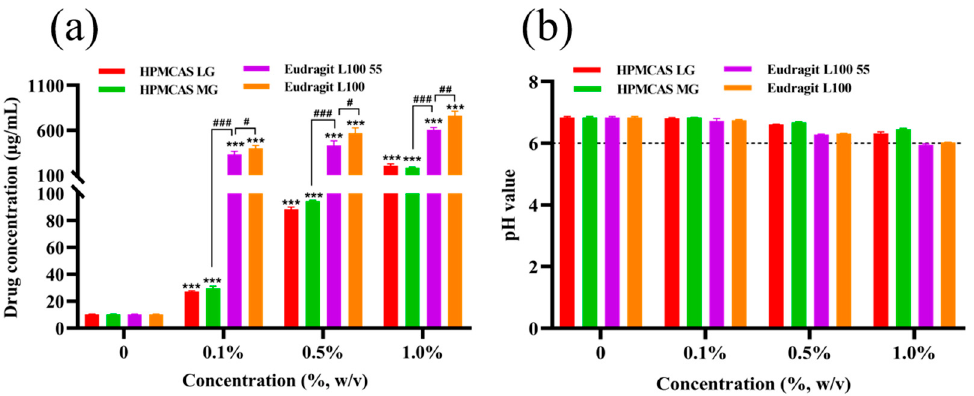
Figure 3. Nintedanib solubility ( a ) and pH values ( b ) of PBS buffer in presence and absence of polymers at different concentrations (0.1%, 0.5%, and 1.0% w / v ) ( n = 3). *** p < 0.001 significantly compared to the blank polymer group. # p < 0.05, ## p < 0.01, ### p < 0.001.